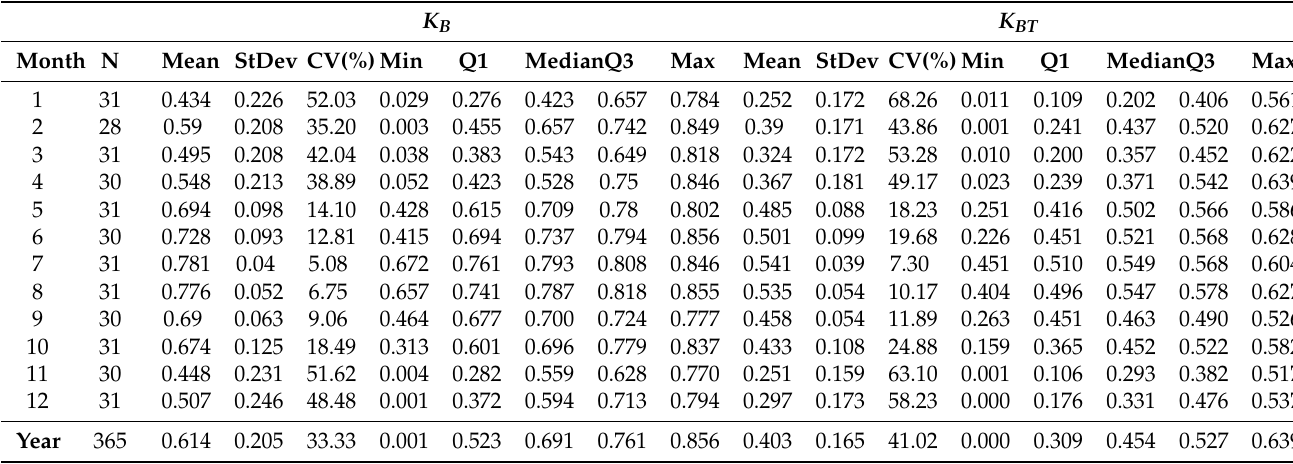
Figure 28. ( a ) relation between K D and K T ; and ( b ) relation between K D and σ . Daily Direct Horizontal Fraction ( K B ) and Daily Direct Transmittance ( K BT ) The characteristic of these relations is that the coefficients of determination are closed to 0.9. The daily direct horizontal fraction is the ratio of daily direct to the daily global ir- radiation, while the direct transmittance is the ratio of direct horizontal to the extrater- restrial irradiation. Table 12 presents the descriptive statistics of these indices. K B ranges from 0.434 in January to 0.781 in July. The daily maximum values exceed 0.75 during the winter months and 0.8 in the rest of the months. K BT ranges from 0.25 in January to 0.541 in July. Maximum values exceed 0.5 throughout the year. Table 12. Descriptive statistics of the daily fraction of direct to global radiation ( K B ) and daily direct transmittance ( K BT ).